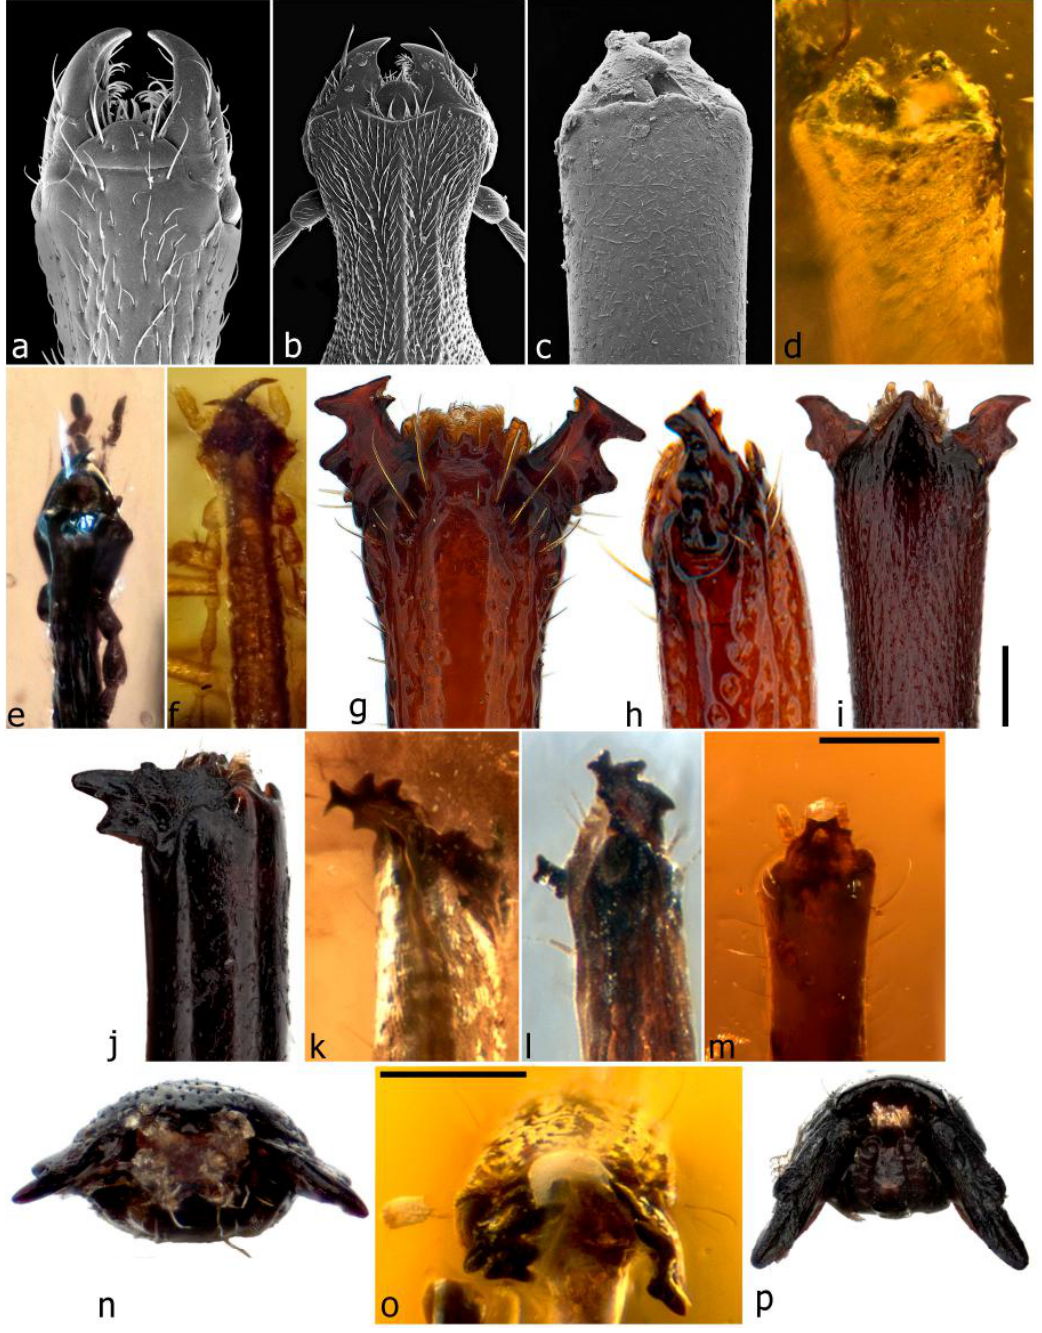
Figure 4. Apical part of rostrum showing mouthpart structures relevant to the classification of Burmese amber weevils. Basiliorhinus araucariae (Nemonychidae), dorsal view ( a ); Telala sp. (Anthribidae), dorsal view ( b ); Car cf. condensatus (Caridae), dorsal view ( c ); Petalotarsus sp. (Mesophyletidae), dorsal view ( d ); Guillermorhinus longitarsis (Nemonychidae), dorsal view ( e ); Burmonyx zigrasi (Nemonychidae), dorsal view ( f ); Rhodocyrtus cribripennis (Attelabidae), dorsal view ( g ); Rhodocyrtus cribripennis (Attelabidae), lateral view ( h ); Meriphus fullo (Curculionidae: Eugnomini), dorsal view ( i ); Ergania gibba (Curculionidae: Curculionini), dorsolateral view ( j ); Acalyptopygus brevicornis (Mesophyletidae), dorsolateral view ( k ); Louwiocis megalops (Mesophyletidae), lateral view ( l ); Elwoodius conicops (Mesophyletidae), dorsal view ( m ); Meriphus fullo (Curculionidae: Eugnomini), apical view ( n ); Habropezus kimpulleni (Mesophyletidae), apical view ( o ); Ergania gibba (Curculionidae: Curculionini), apical view ( p ). Scale bars: 0.1 mm (o); 0.2 mm (i,m).